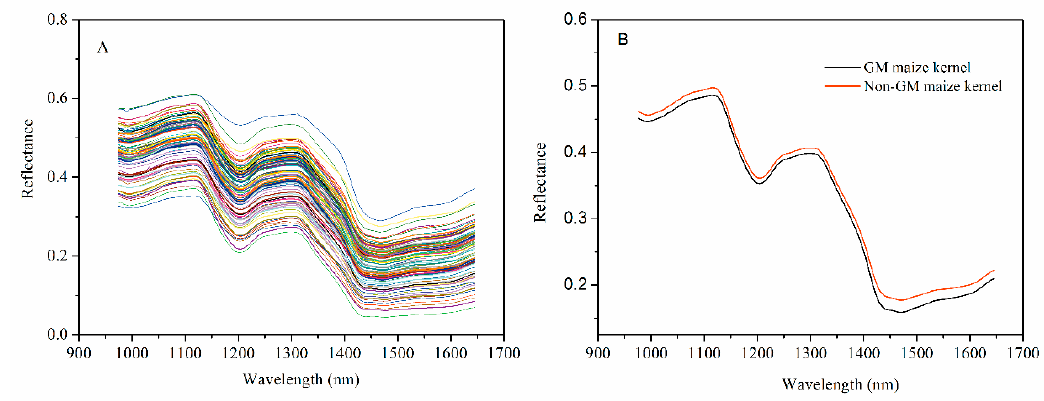
Figure 3. The profiles for raw spectra ( A ) and average spectra reflectance ( B ) from the near-infrared (NIR) multispectral images of GM and non-GM maize kernels.